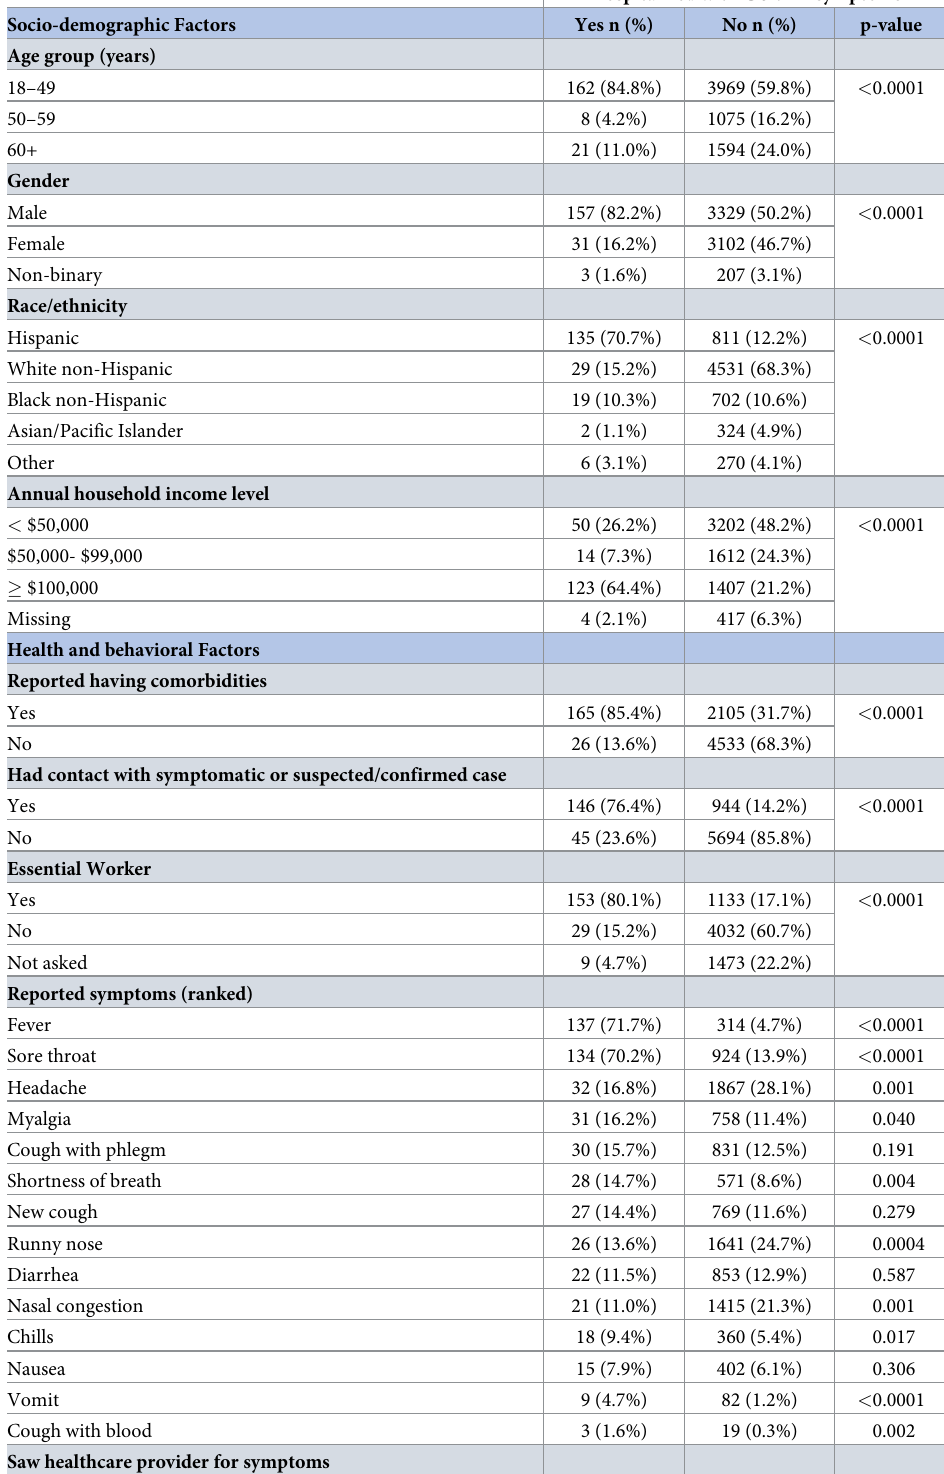
Table 3. Characteristics of participants by status of hospitalization with COVID-like symptoms, April